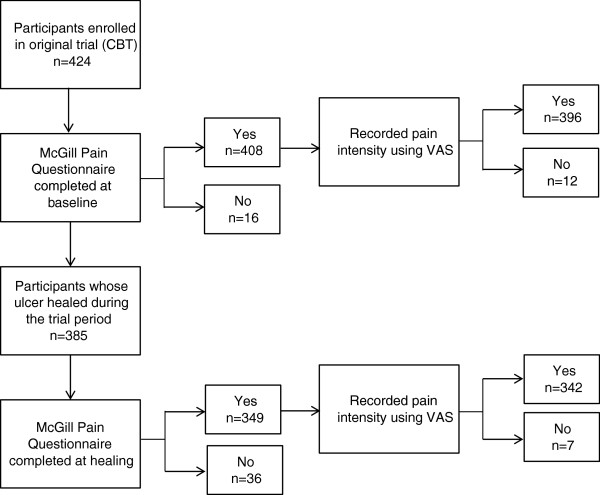
Recruitment and data collection.